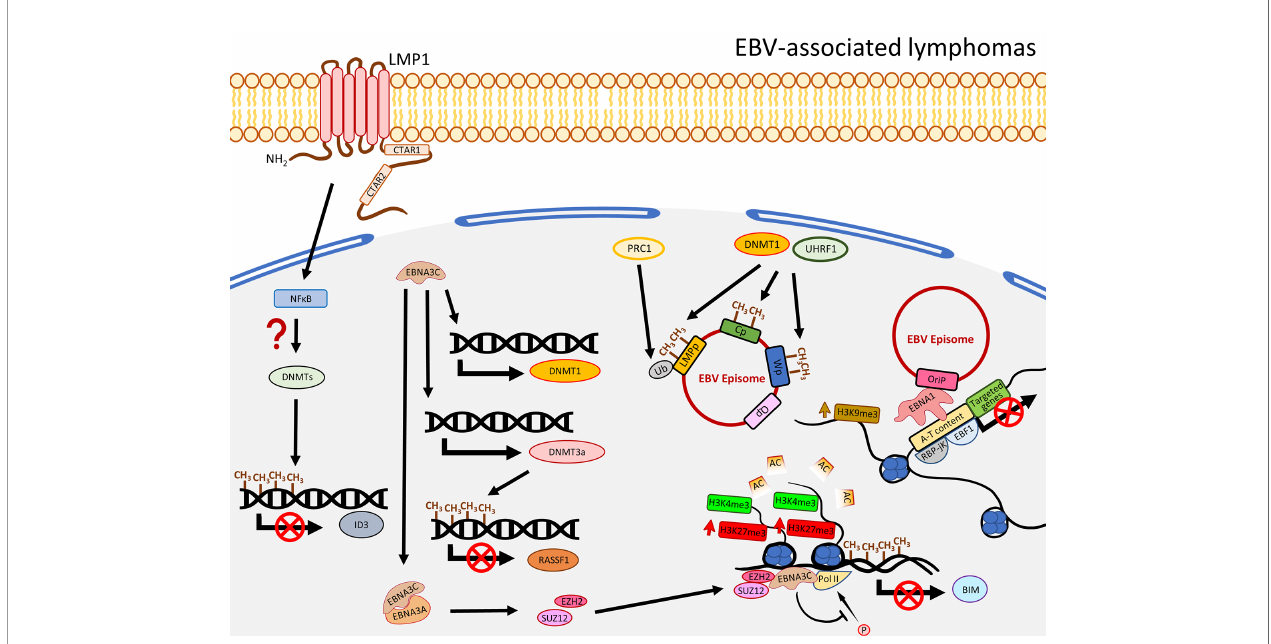
FIGURE 3 | A schematic diagram shows the impact of EBV on epigenetic dysregulation in EBV-associated lymphomas. LMP1 and NF k B are required to suppress the expression of ID3 via promoter methylation by a recruitment of the DNMT complex. EBNA3C promotes expression of DNMT3a to induce DNA methylation, resulting in suppression of gene expression including RASSF1 . EBNA3C also interacts with EBNA3A to regulate the histone bivalent switch to recruit EZH2 and SUZ12 to the BIM promoter to regulate the expression, with evidence of the relevant promoter methylation. The EBV C promoter (Cp), W promoter (Wp), and LMP promoter (LMPp) are restricted by the host factors, including DNMT1 and UHRF1, through DNA methylation, or mono-ubiquitination of the LMPp by PRC1 (Ub: H2AK119Ub1). The interactions of EBV and host genome, through EBNA1 tethering, are associated with gene silencing and enriched with enhanced H3K9me3, A-T content, RBP-jK, and